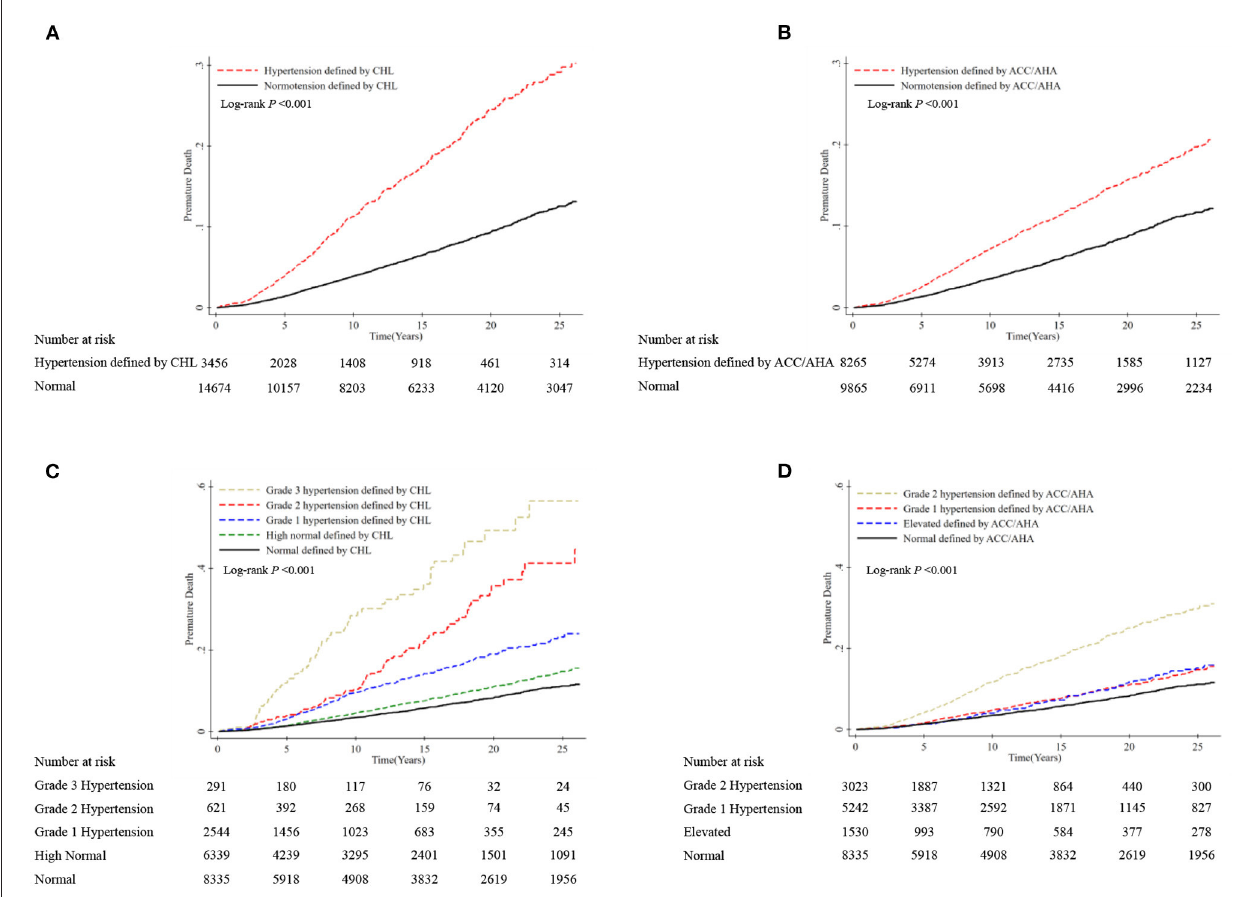
FIGURE 3 | Cumulative incidence of premature mortality according to hypertension categories by CHL and ACC/AHA definition. Premature death is defined as deaths before the age of 73.64 years in men and 79.43 years in women. (A) Hypertension was defined as SBP ≥ 140 mmHg, DBP ≥ 90 mmHg, or taking antihypertensive medication according to the CHL guidelines; (B) hypertension was defined as SBP ≥ 130 mmHg, DBP ≥ 80 mmHg, or taking antihypertensive medication according to the 2017 ACC/AHA guidelines; (C) participants were categorized as having normal BP (untreated SBP < 120 mmHg and DBP < 80 mmHg); high normal BP (untreated SBP 120–139 mmHg and/or DBP 80–89 mmHg); Grade 1 hypertension (SBP 140–159 mmHg and/or DBP 90–99 mmHg); Grade 2 hypertension (SBP 160–179 mmHg and/or DBP 100–109 mmHg); and Grade 3 hypertension (SBP ≥ 180 mmHg and/or DBP ≥ 110 mmHg) according to the CHL guidelines; (D) participants were categorized as having normal BP (untreated SBP < 120 mmHg and DBP < 80 mmHg); elevated BP (untreated SBP 120–129 mmHg and/or DBP < 80 mmHg); Grade 1 hypertension (SBP 130–139 mmHg and/or DBP 80–89 mmHg); and Grade 2 hypertension (SBP ≥ 140 mmHg and/or DBP ≥ 90 mmHg) according to the 2017 ACC/AHA